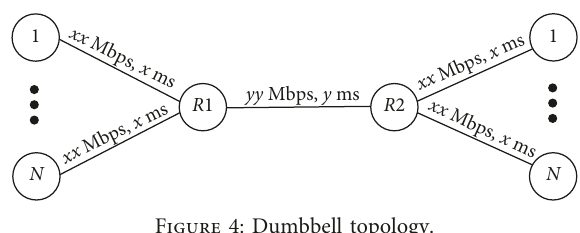
Figure 4: Dumbbell topology.